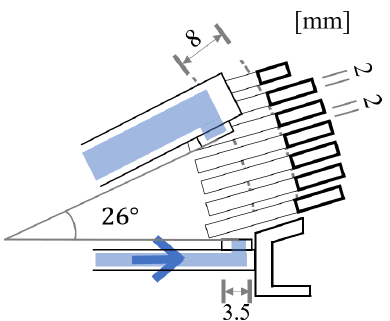
Figure 5. Structure and dimensions of the contacts and splitter plate.